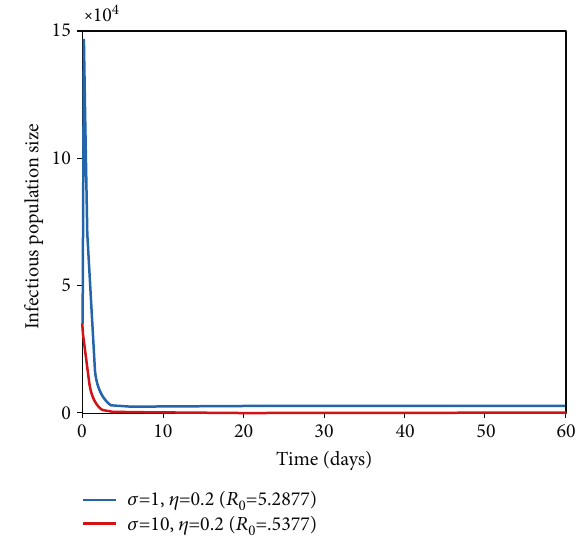
Figure 13: The e ff ect of σ and η on the number of infectious